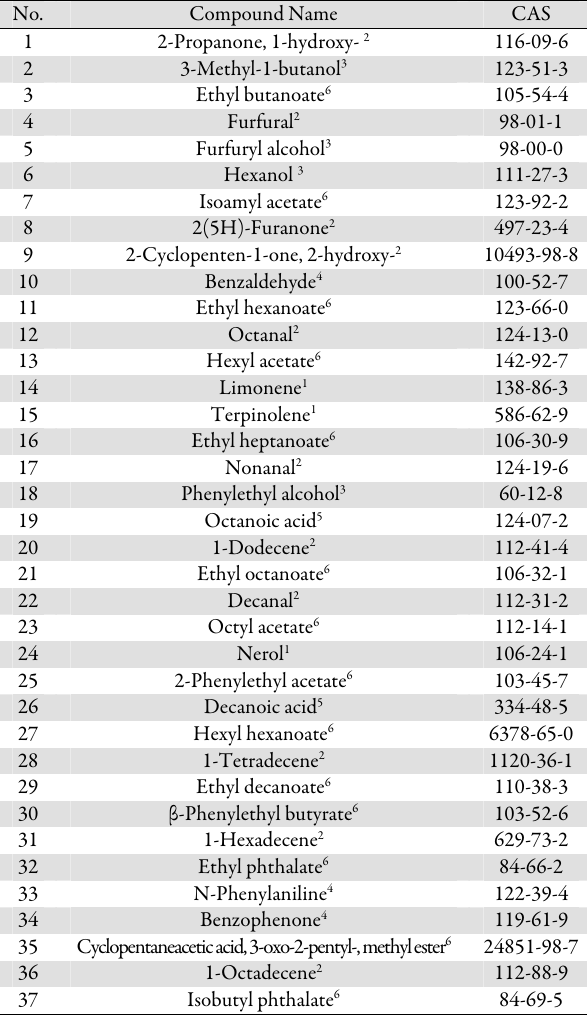
Table 2. Non polar compounds identified in wine No.